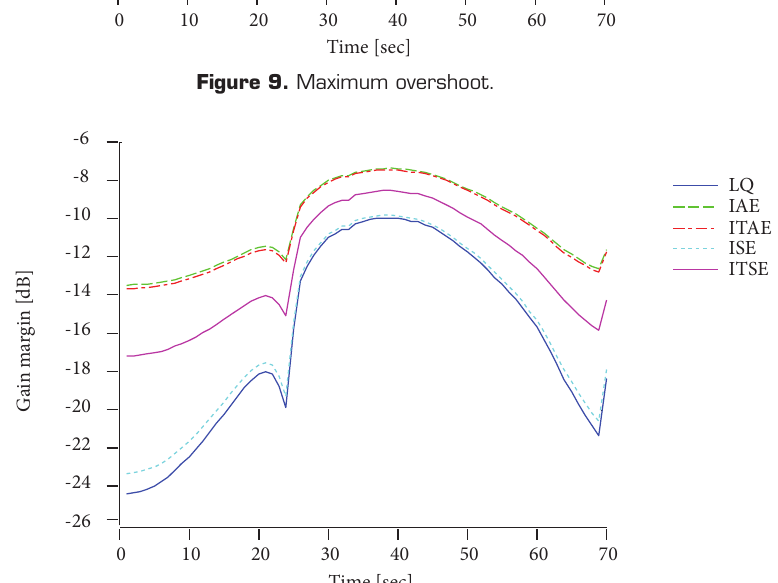
Figure 9. Maximum overshoot.